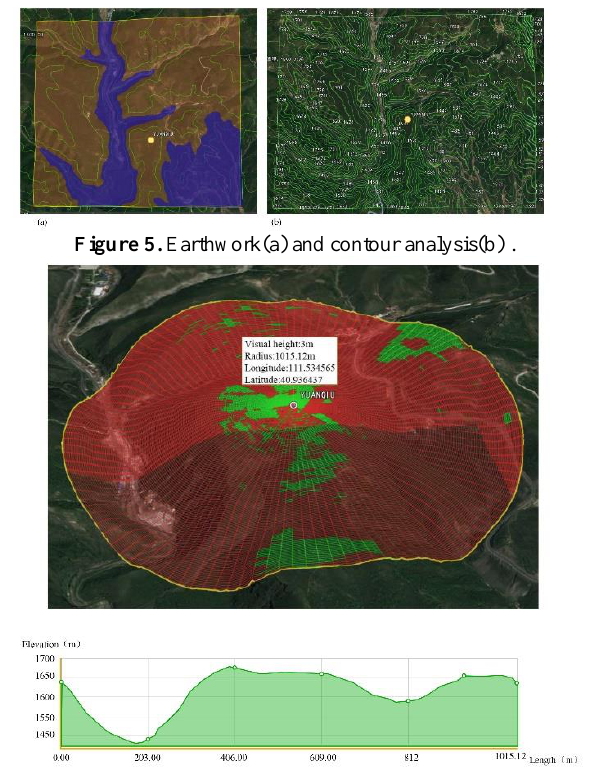
Figure 6. Visible area (invisible area in red) and